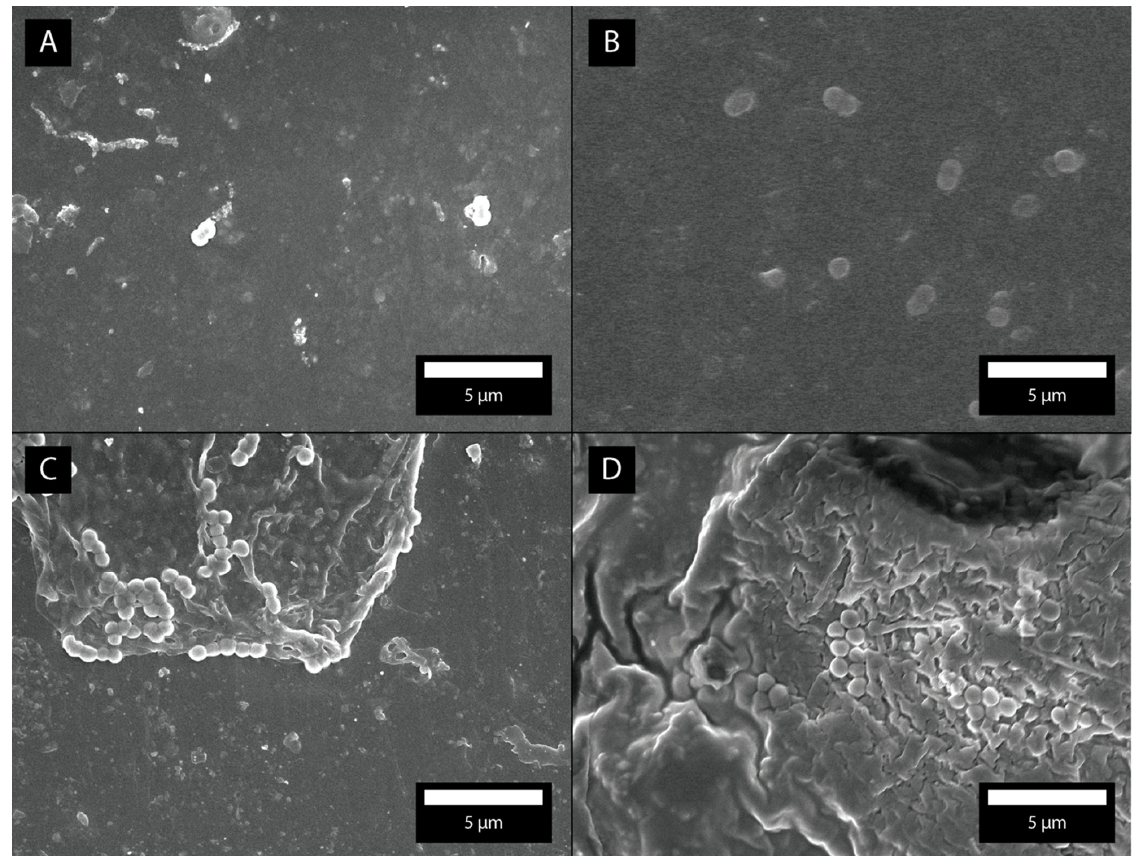
Figure 9. SEM micrographs of ( A ) PMMA, ( B ) EVA/LDPE with Ag nanoparticles, ( C ) silicone, and ( D ) TPE surfaces with adhered S. epidermidis . adhered S. epidermidis